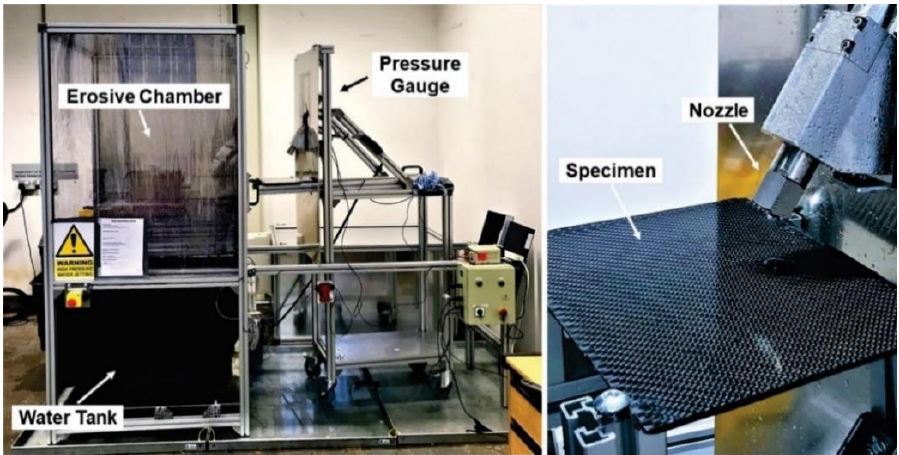
Figure 4. Water jet erosion platform.